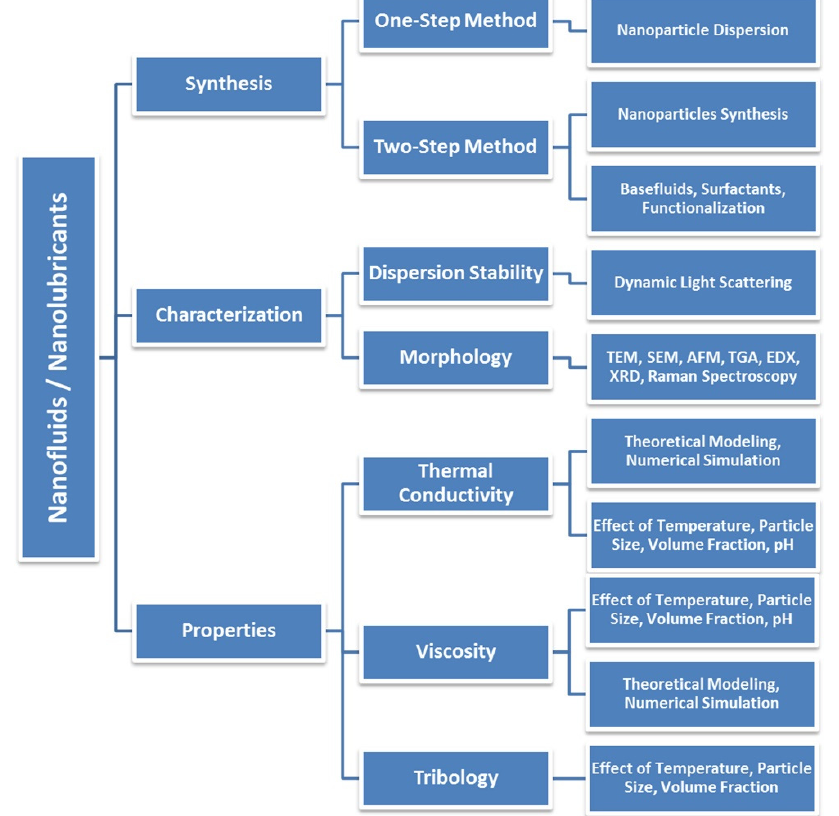
Figure 9. Nanofluids and nano-lubricants research areas and methodology (reproduced from [13] with permission from Elsevier).